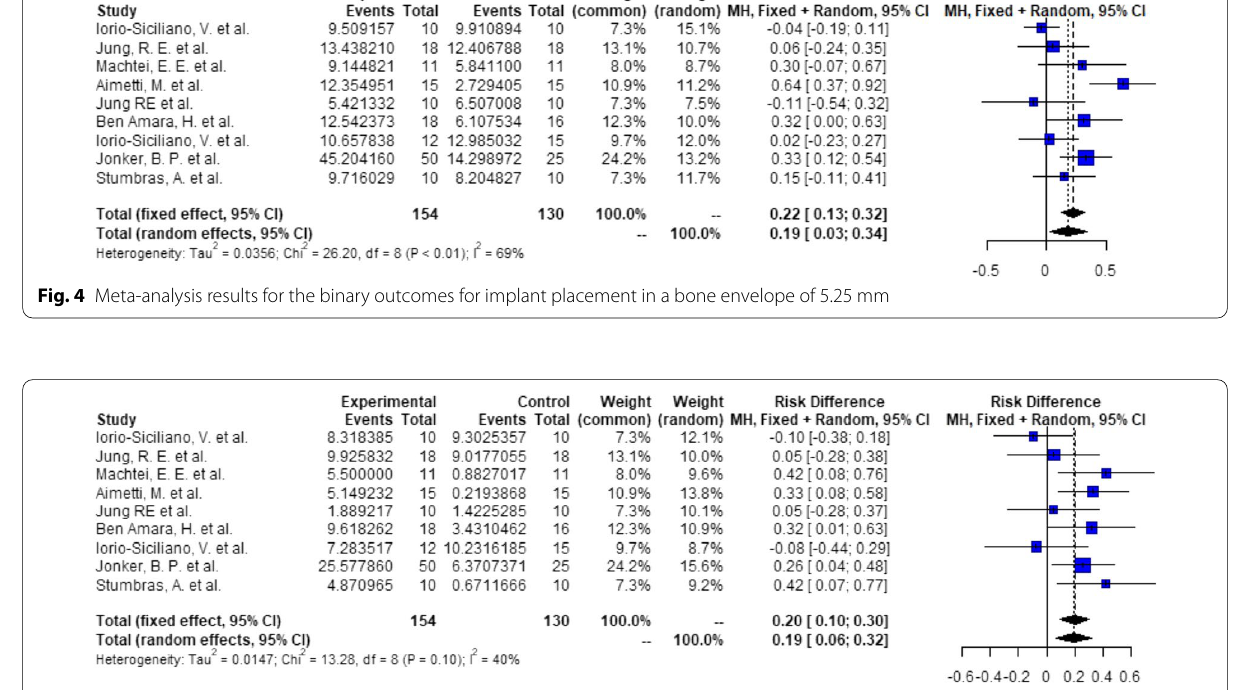
Fig. 5 Meta-analysis results for the binary outcomes for implant placement in a bone envelope of 7.25